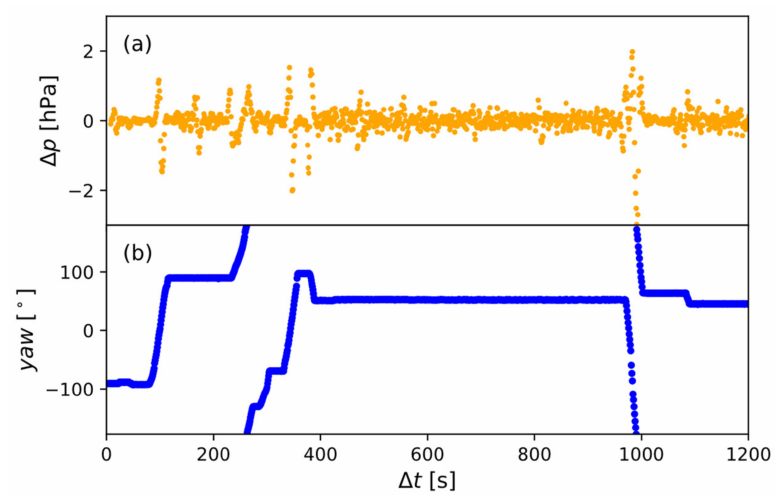
Figure 7. Measurement anomalies of pressure background trend removed with a moving average window size of 16s to capture yaw-related variations during ascent from 0 m to 50 m above ground level of a payload test flight ( a ). As seen from the UAV yaw values ( b ), occurrences of measurement anomalies of pressure coincide with yaw value variations at respective time